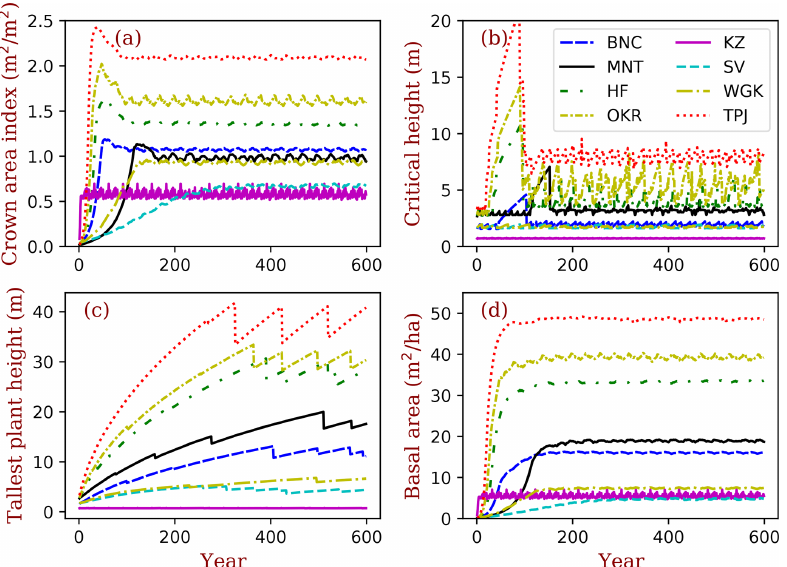
Figure 3. Vegetation structural dynamics with the full demographic BiomeE at the field sites listed in Table 2. Critical height (b) is an index of the model PPA, which separates the trees that are in full sunlight if taller than critical height and those that are fully shaded if shorter than critical height.